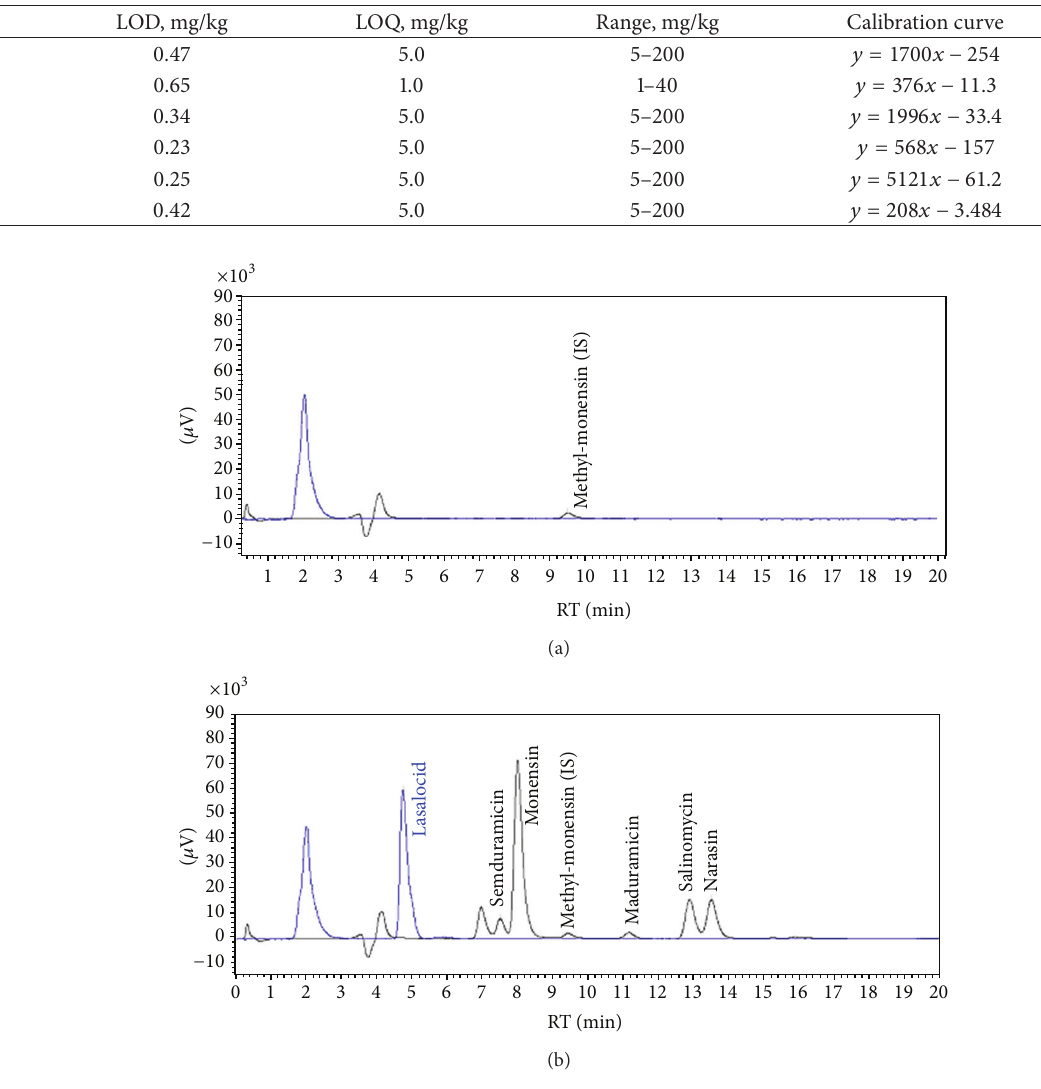
Figure 3: Chromatograms of blank poultry feed sample (a) and feedsample spiked with 50mg/kg LAS, MON, NAR, SAL, SMD, and 10 mg/kg MAD